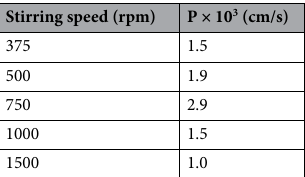
Table 1. Influence of stirring speed on the permeability (P) of indium(III). P value, as in the rest of the work, calculated as in Eq. (12).